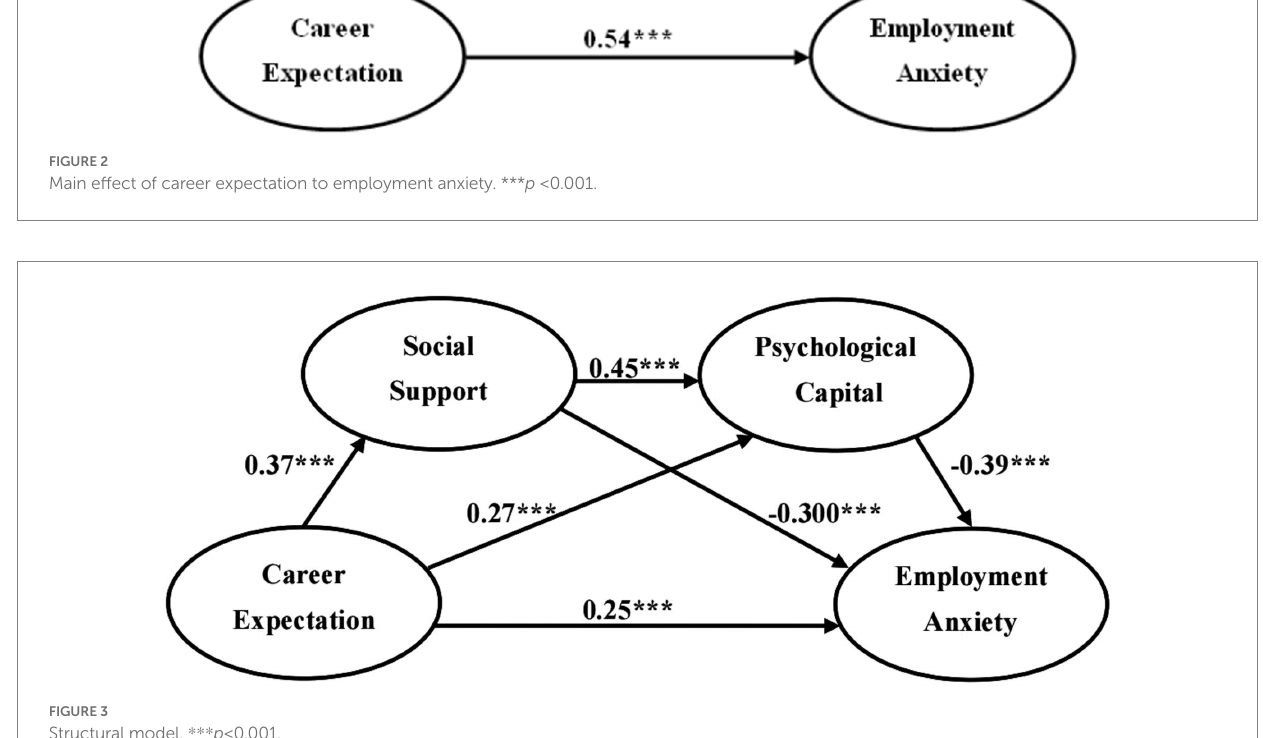
FIGURE 3 Structural model. *** p < 0.001.